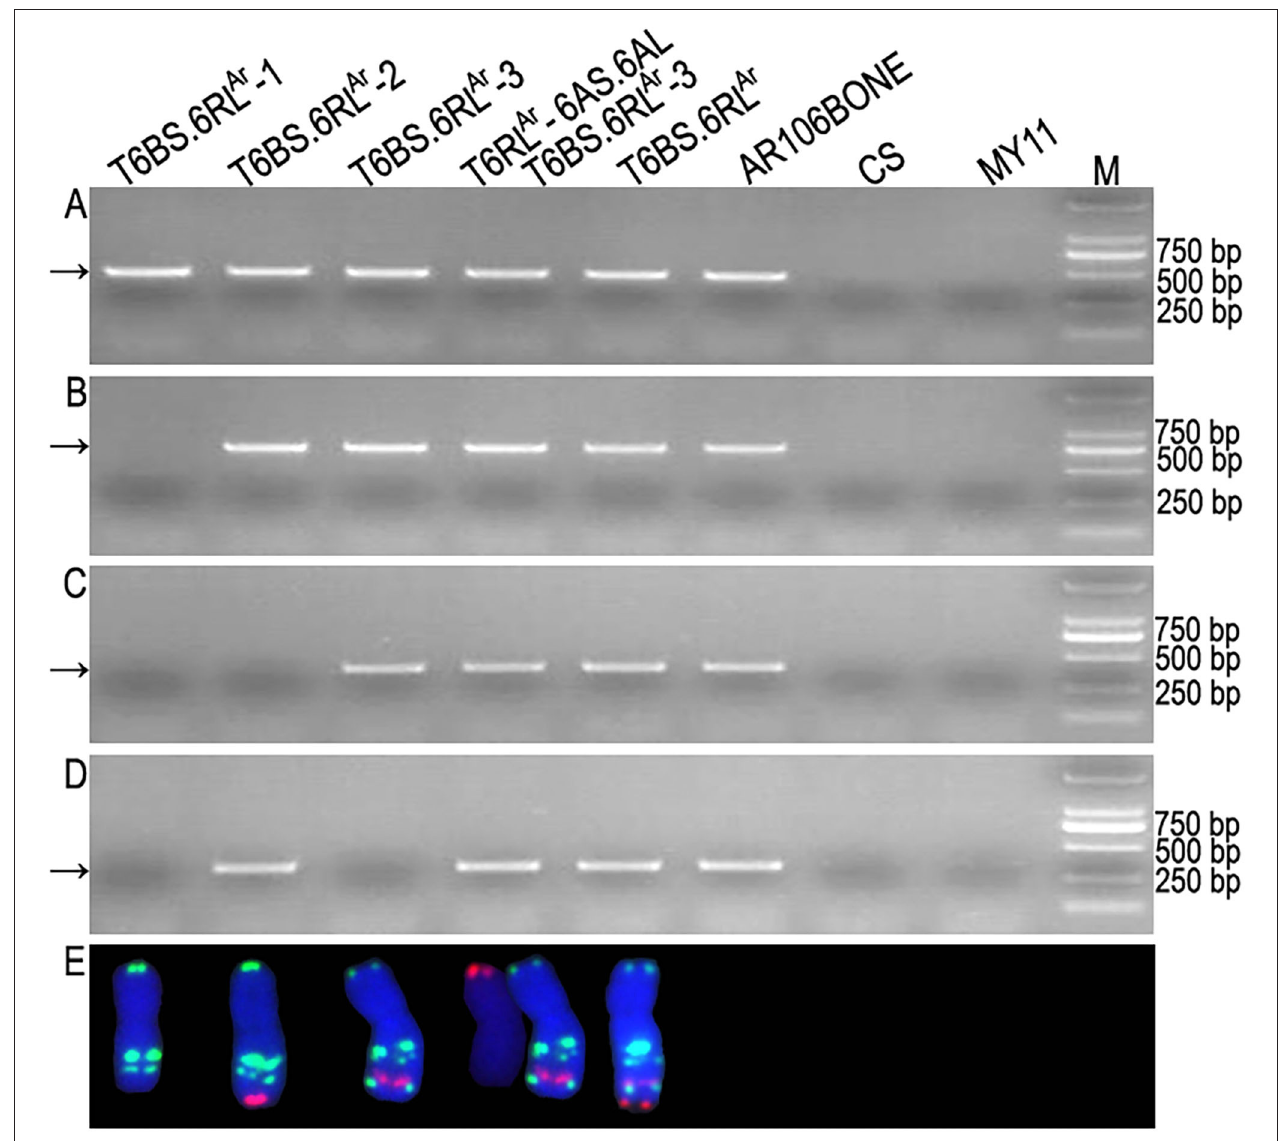
FIGURE 4 | Physically mapped 6RL Ar -specific markers using deleted T6BS.6RL Ar translocations. (A) Products amplified by primer pair Lo7.6RL-2 represent the markers located on T6BS.6RL Ar and all the deleted T6BS.6RL Ar . (B) Products amplified by primer pair Lo7.6RL-74 represent the markers located on T6BS.6RL Ar , T6BS.6RL Ar -2, and T6BS.6RL Ar -3. (C) Products amplified by primer pair Ku.6RL-260 represent the markers located on T6BS.6RL Ar and T6BS.6RL Ar -3. (D) Products amplified by primer pair Lo7.6RL-183 represent the markers located on T6BS.6RL Ar , T6BS.6RL Ar -2, and T6RL Ar -6AS.6AL. (E) Cut-and-paste translocation chromosomes corresponding to their amplified products in each electrophoresis lane. Arrows indicate the target bands amplified by 6RL Ar -specific markers. Common wheat Chinese Spring (CS), Mianyang11 (MY11), and rye AR106BONE were used as controls. M: DNA marker.